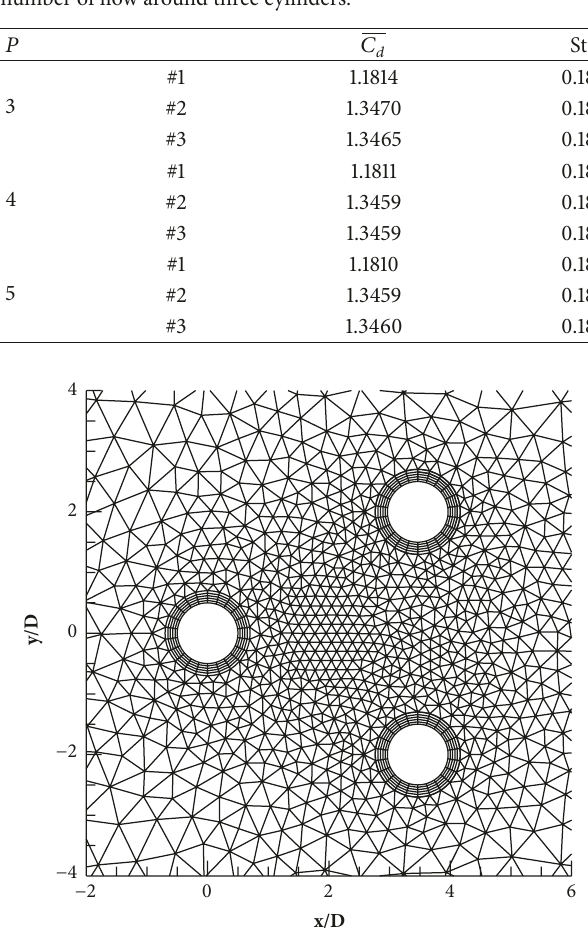
Figure 13: Local refined mesh around the three circular